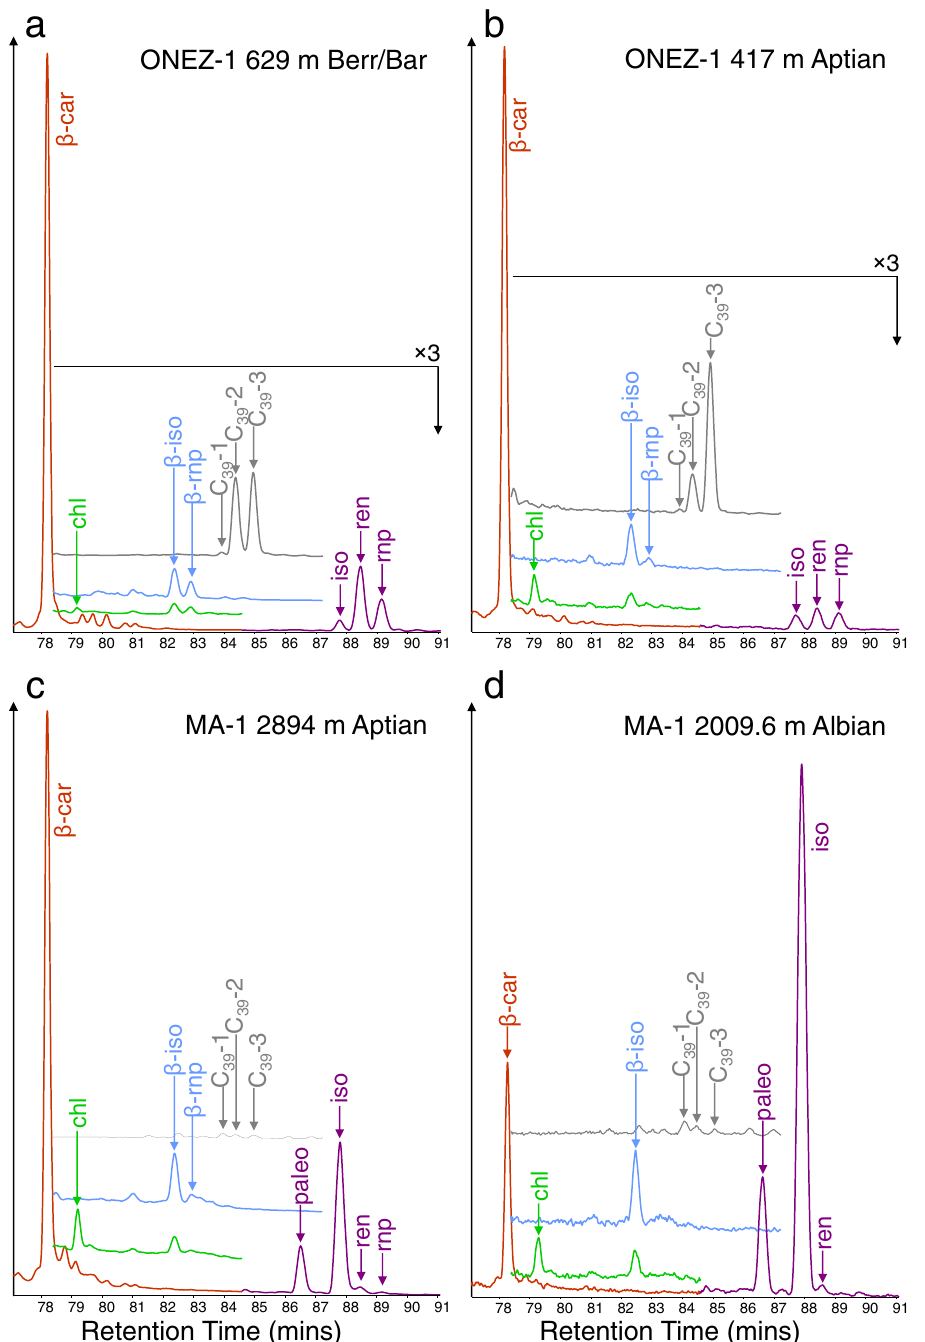
Fig. 4 Four representative chromatograms of carotenoid hydrocarbons. a , b are from samples of Aptian and Berriasian/Barremian (Berr/Bar) ages, respectively, from ONEZ-1 well, while ( c ) and ( d ) are samples of Albian and Aptian ages, respectively, from Maculungo-1 (MA-1) well. The lacustrine deposition, as of ( a ), is typi fi ed by high β -carotane ( β -car) relative to aromatic carotenoids, while the marine deposition, as of ( d ) is characterized by high C 40 aromatic carotenoids (e.g., isorenieratane — iso and paleorenieratane — paleo). β -iso: β -isorenieratane; β -rnp: β -renierapurpurane; C 39 -1 to C 39 -3: three diaromatic carotenoid isomers with 39 carbon atoms without de fi nitive structures. See Fig. 2 for additional